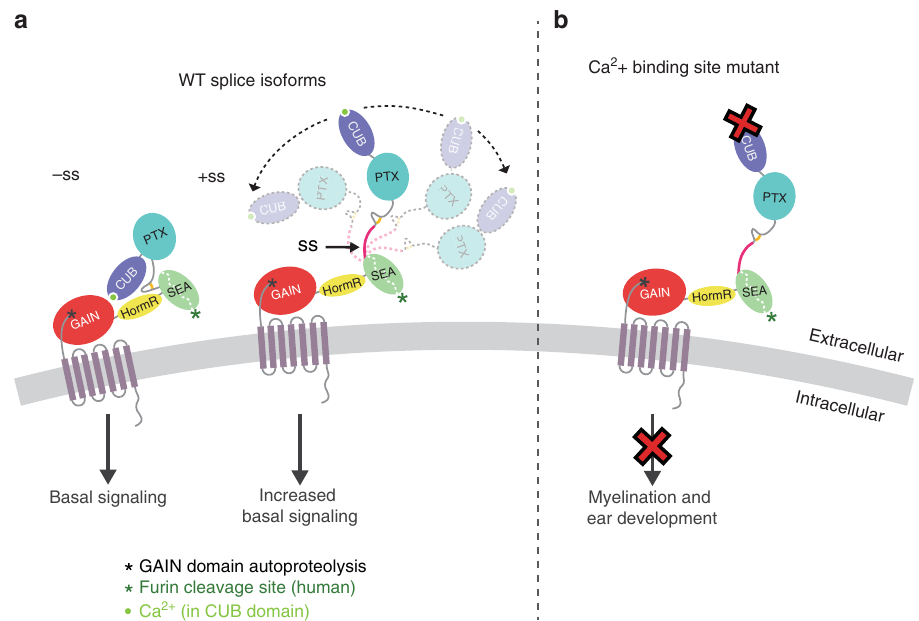
Fig. 7 Model for ECR-dependent functions of Gpr126. The model depicts how Gpr126/GPR126 function is regulated by its ECR. a Alternative splicing acts as a molecular switch to adopt different ECR conformations and have different basal levels of signaling. Gpr126 ECR that lacks the splice insert adopts a closed conformation and has basal activity, whereas Gpr126 ECR that includes the splice insert (magenta) is more dynamic and open-like, and has enhanced basal activity. Autoproteolysis in GAIN domain is indicated by a black asterisk. The calcium ion is shown as a bright green circle. b Mutation of conserved residues within the calcium-binding site leads to defects in both myelination and ear development in vivo. Human GPR126 function may also be regulated by furin cleavage, indicated by a green